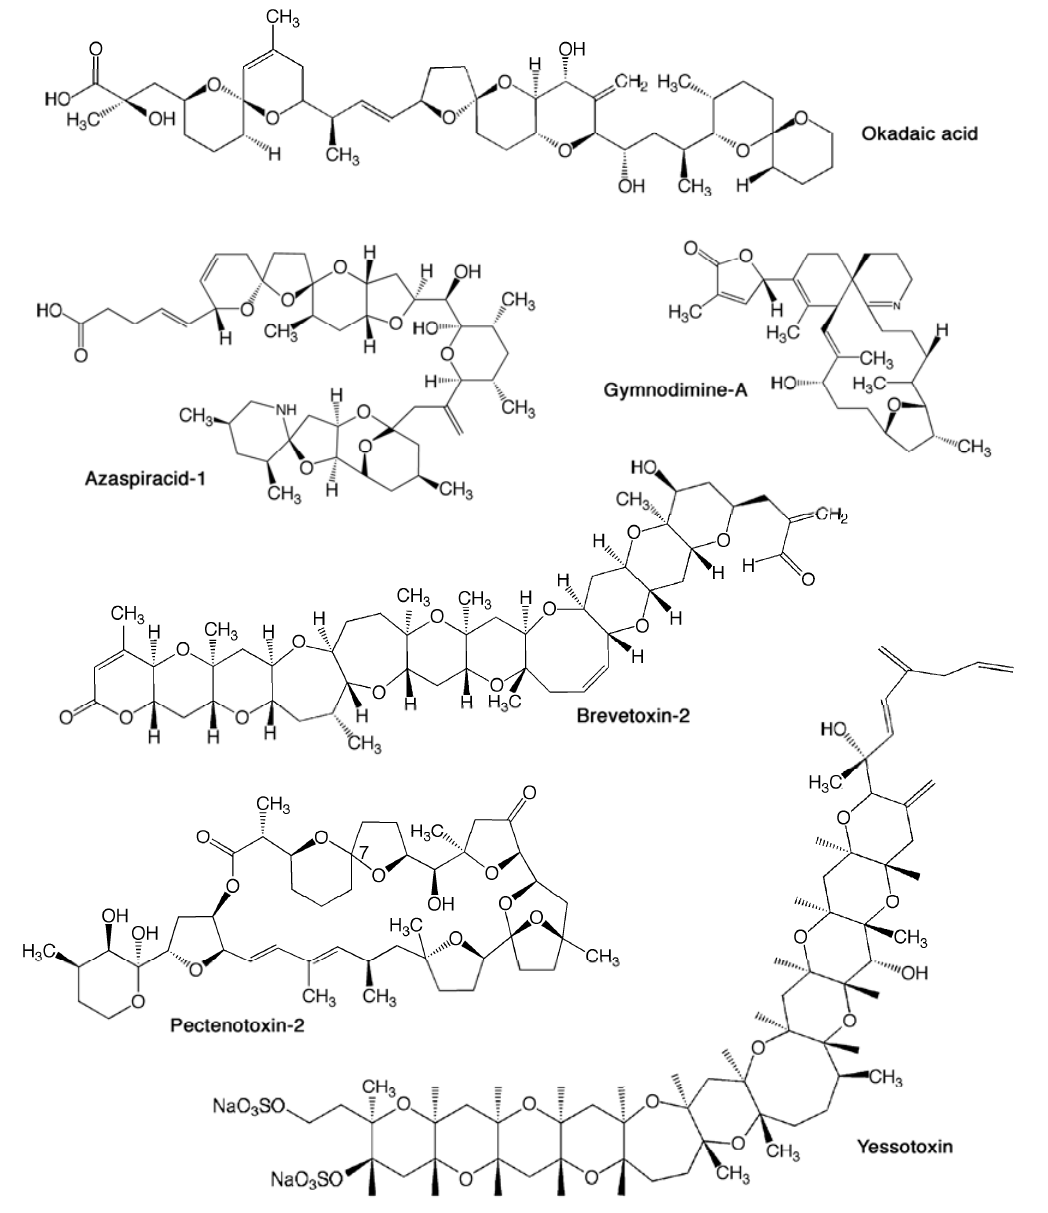
Figure 1. Chemical structures of lipophilic